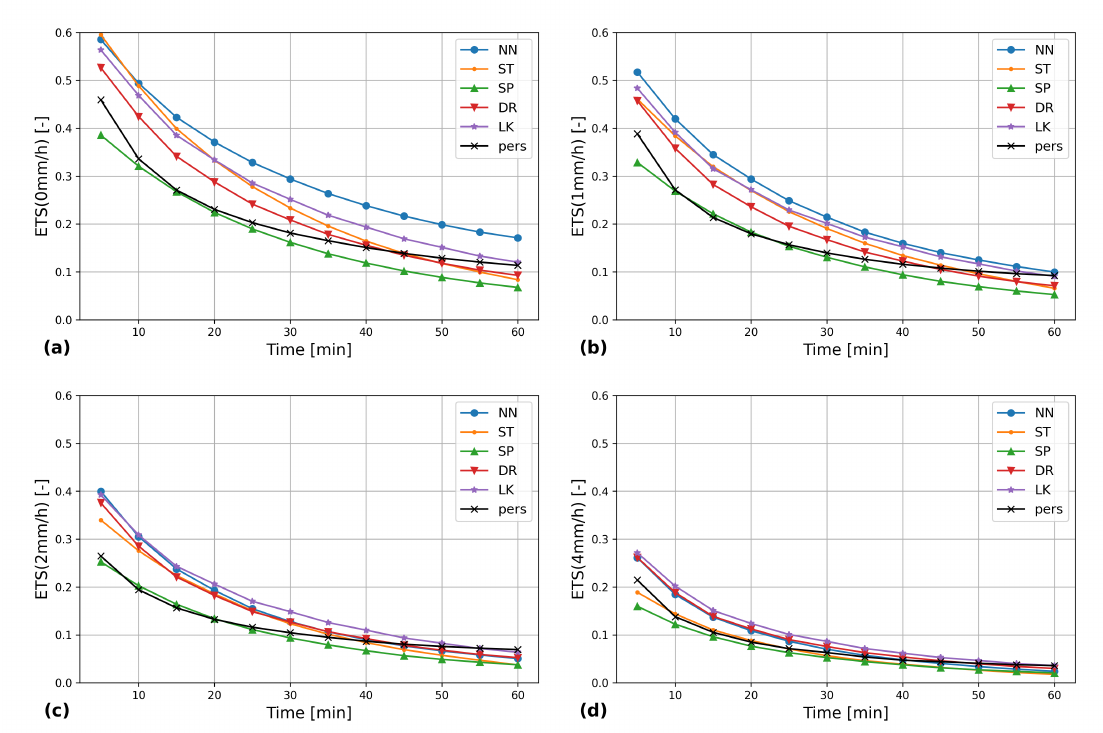
Figure 8. ETS, for 0, 1, 2, 4 mm/h thresholds shown on boxes ( a ), ( b ), ( c ), ( d ) respectively, as function of the forecast time from 1’ to 60’, for all nowcast methods and persistence, for 2017.